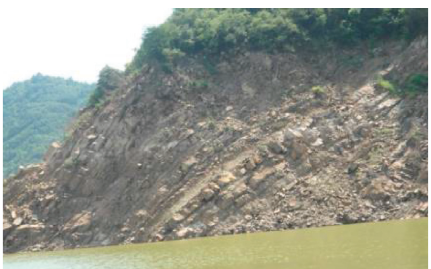
Figure 1: Rock mass destruction photo of typical bank slope hydro-fluctuation belt